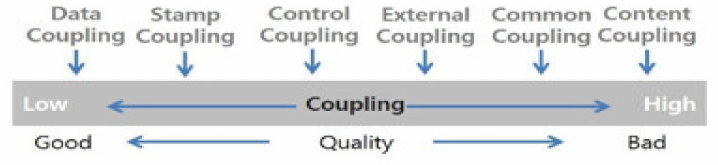
Figure 4. Types of coupling strength.